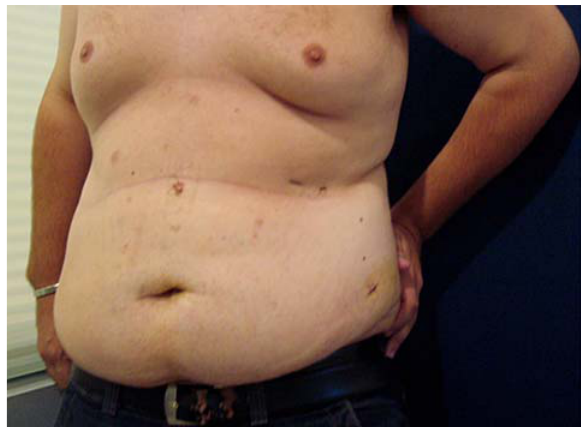
Figure 1 – Patient on the day of